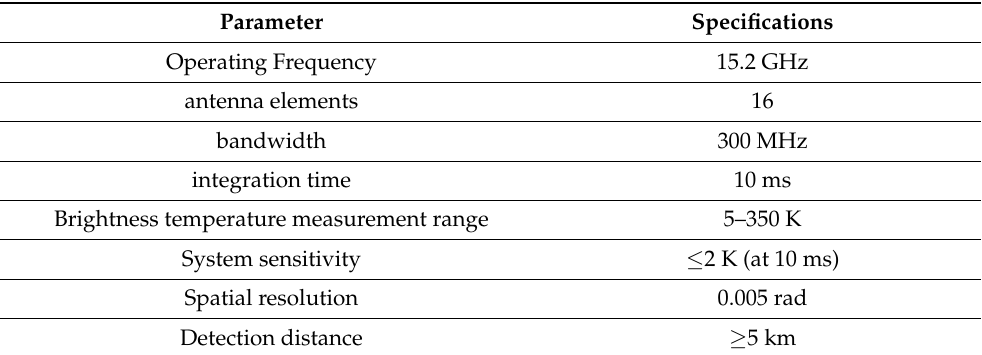
Figure 1. GSAMR system composition block diagram. Table 1. Main Specifications of GSAMR.